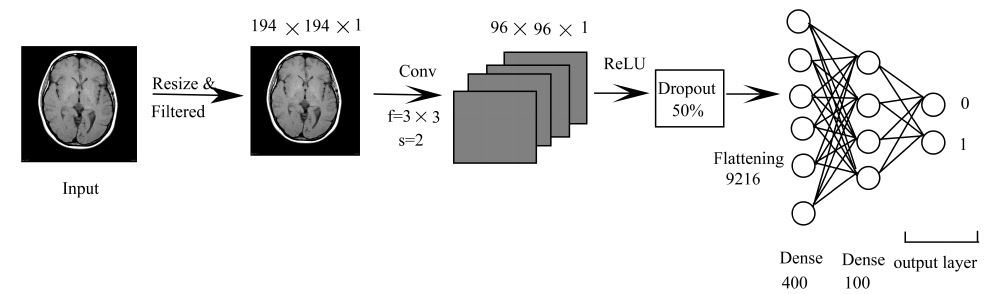
Figure 3. CNN-DNN.